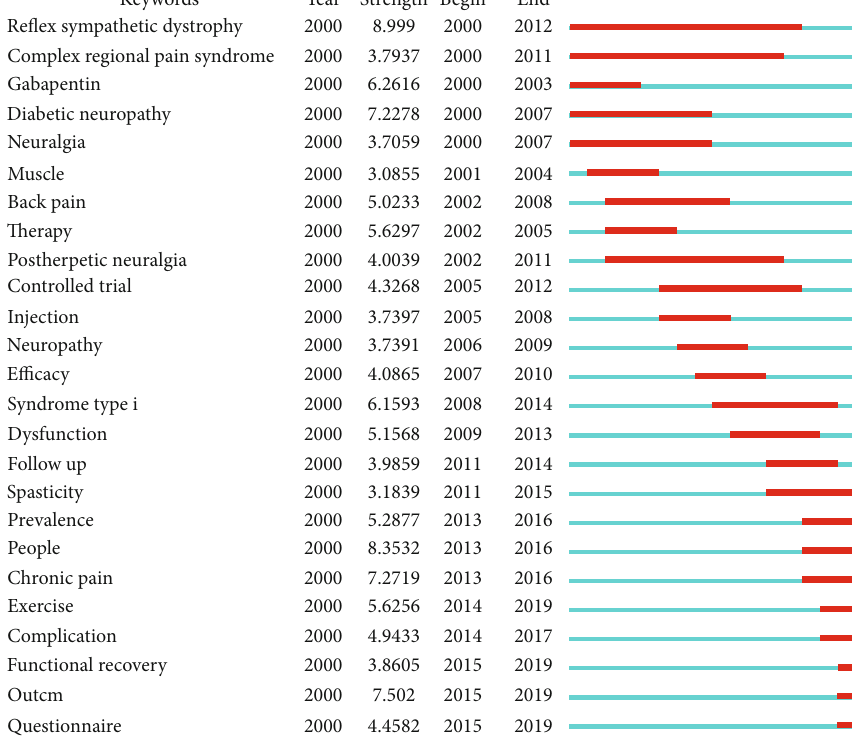
Figure 9: The keywords with the strongest citation bursts of publications on neuropathic pain rehabilitation research.